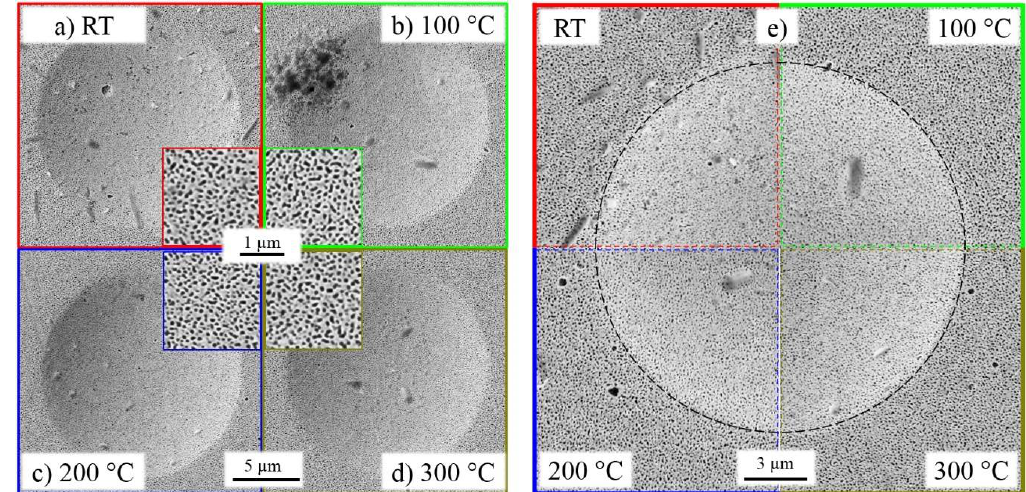
Figure 5. ( a – d ) Residual impressions of HT indentation experiments on NP Au do not show any distinctive features; ( e ) Direct comparison of indentations for each temperature condition verifies that no major drift influences or tip changes were occurring.